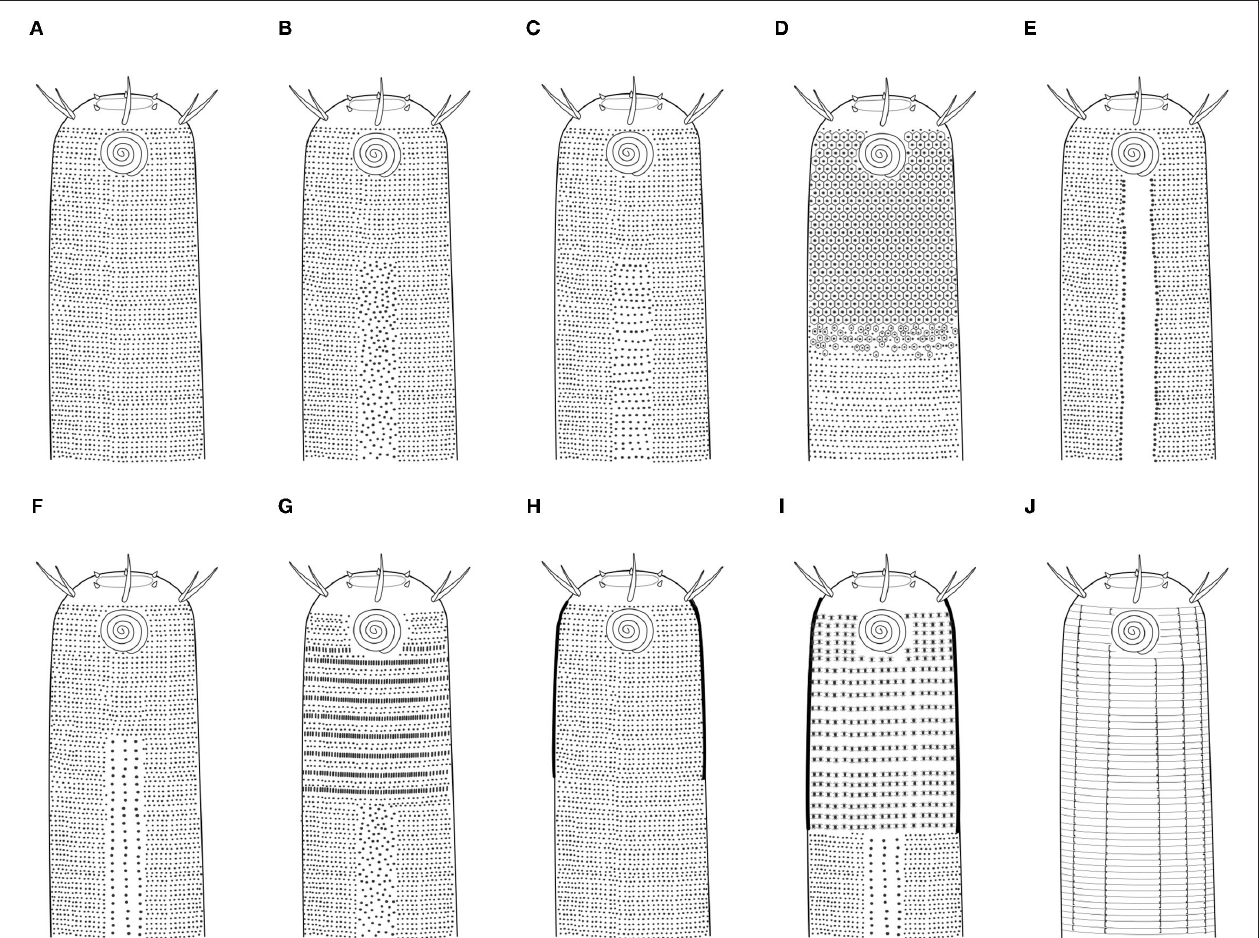
FIGURE 2 | Cuticle pattern of Cyatholaimidae species. (A) Homogeneous, without lateral differentiation; (B) Homogeneous, with lateral differentiation of larger and more sparsely dots irregularly arranged; (C) Homogeneous, with lateral differentiation of larger and more sparsely dots regularly arranged; (D) Heterogeneous, with enlarged hexagonal punctations in the anterior end; (E) Homogeneous, with lateral differentiation of longitudinal rows of enlarged punctations with broad lateral fields between them; (F) Homogeneous, with lateral differentiation of longitudinal rows of punctations; (G) Heterogeneous, with alternating pattern of one or two rows of simple dots and one row of longitudinal bars consisting of two fused dots in anterior end; (H) Heterogeneous, with cuticle in the head thicker; (I) Heterogeneous, with cuticle in the head thicker, and with lateral differentiation of longitudinal rows of enlarged dots; (J) Homogeneous, with rings smooth, not dotted and adorned with 10 marked longitudinal